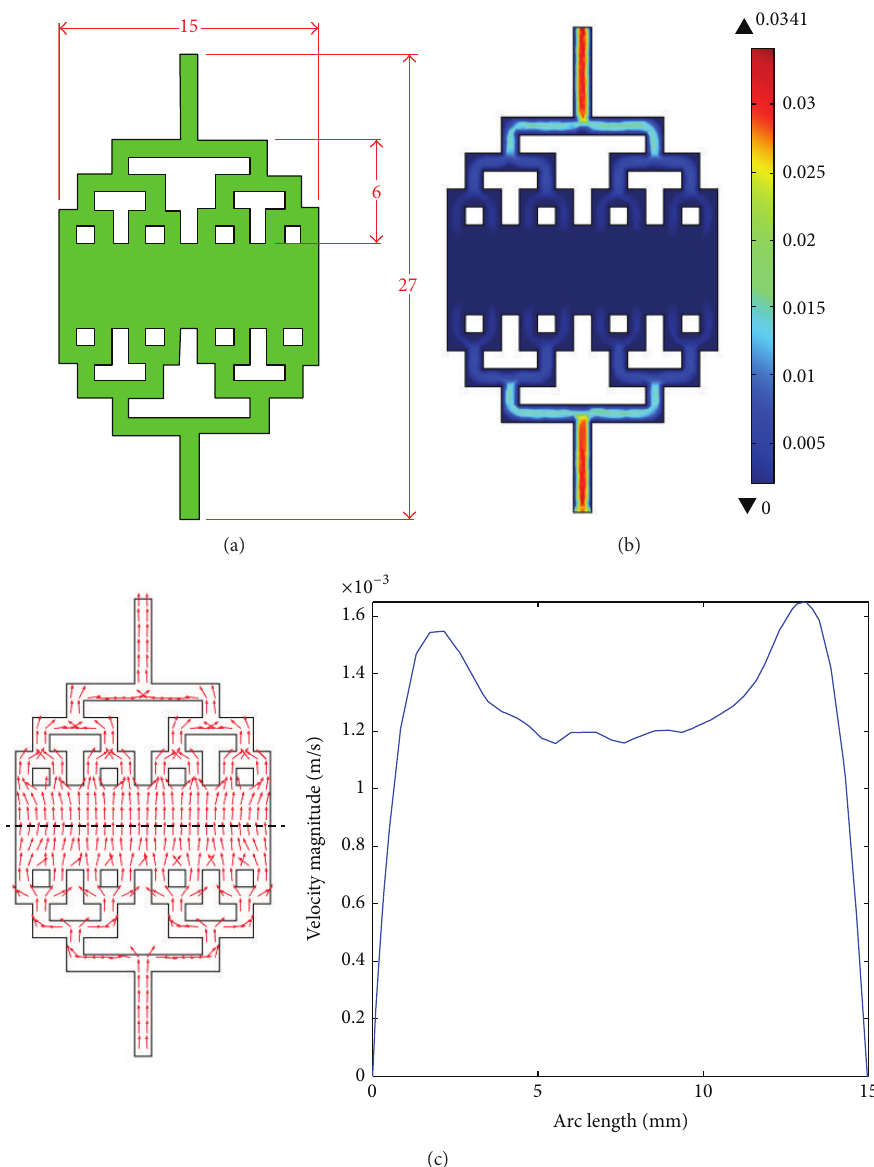
Figure 7: Schematic of (a) microfluidic channel with 3-level of bifurcation with its (b) surface velocity plot; (c) arrow plot and graph of velocity profile at the middle of microfluidic chamber (represented with dash line).